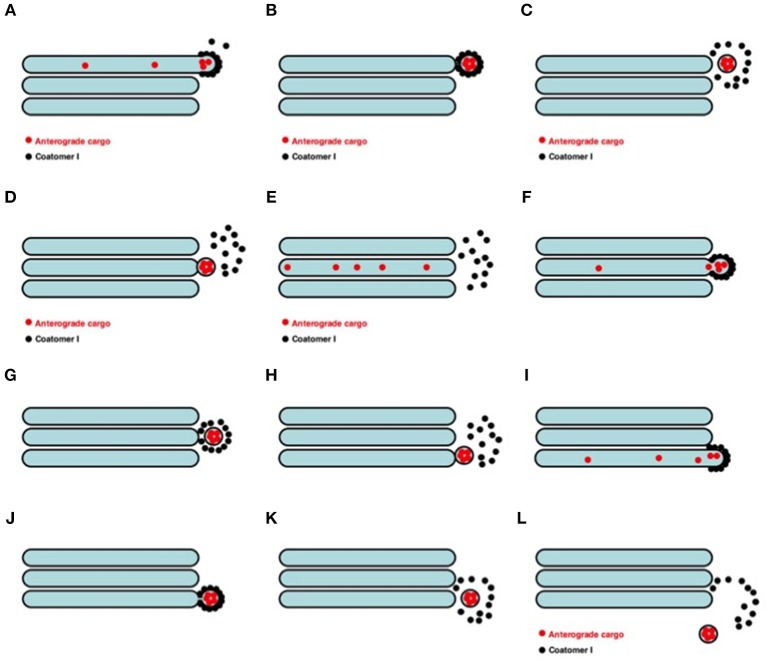
Scheme of the VM for intra-Golgi transport (see also movie https://yadi.sk/i/M1ykjxKabmjs5). (A) COPI (black dots) forms a coat on a membrane bud. A cargo (red dots) is concentrated inside the COPI-coated bud. (B, C) This bud undergoes detachment (B) and uncoating (C). (D) The vesicle fuses with the distal Golgi compartment. (E) Distribution of the cargo within the next Golgi cisterna. (F–H and I–L) Repetition of the first stage. Finally, the vesicle can move out the Golgi (L).